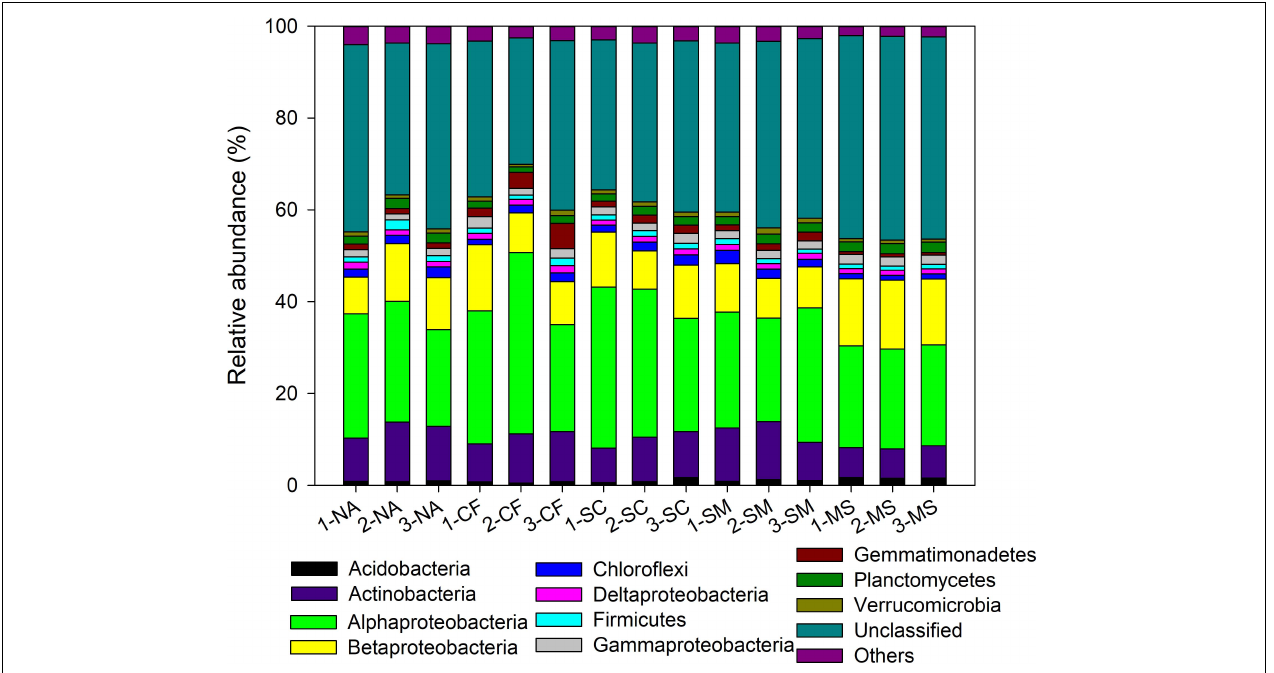
FIGURE 2 | Relative abundance of the autotrophic bacterial phyla under five treatments. NA, no amendment; CF, chemical fertilizer; SC, 50% chemical N fertilizer plus 50% organic N fertilizer; SM, organic fertilizer; MS, maize straw. The numbers before the treatment name indicate the sampling replications. For example, 1-NA, 2-NA, and 3-NA mean the sampling was taken from replicates 1, 2, and 3 of the field plots, respectively.